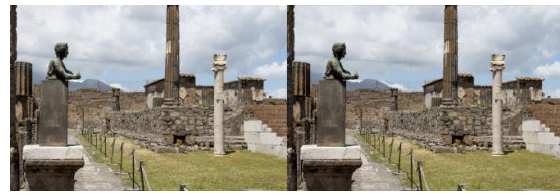
Figure 3. Stereoscopic shots Apollo’s Temple